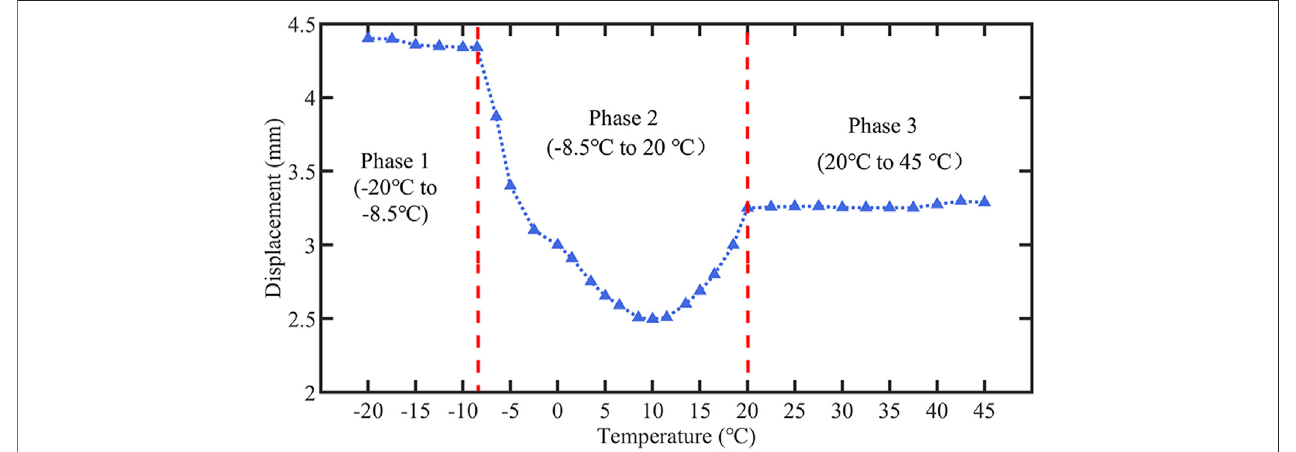
FIGURE 9 | Displacement response of portal frame in frequency domain.